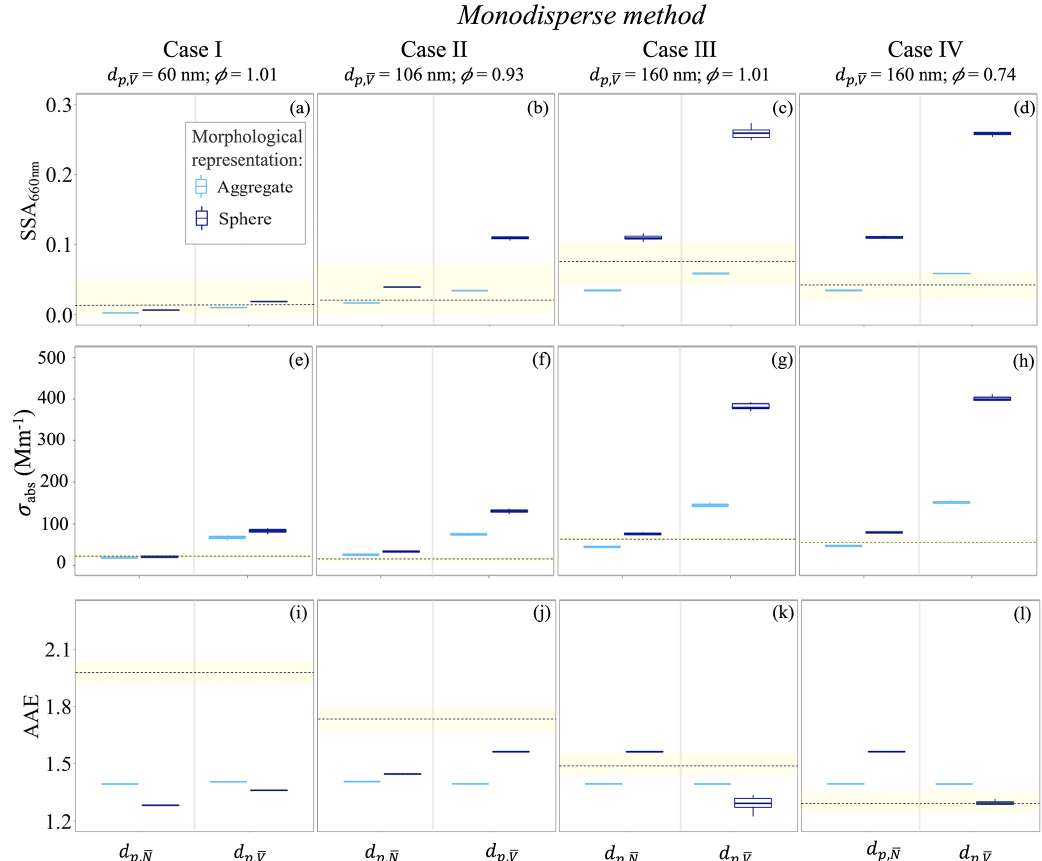
Figure 5. Optical properties of bare BC particles modelled using the monodisperse method compared to their measured values. Panels (a) – (d) show single-scattering albedo (SSA), and panels (e) – (h) show Ångström absorption exponent (AAE) for cases I–IV of E1. In each panel or case, the “sphere” and “aggregate” representations for bare BC particles were used, as shown in the legend. The SSA and AAE are modelled using both d and d ( x axis). The shaded yellow area represents the experimentally measured values, with the dashed line p ,N p ,V being the mean of the measured SSA or AAE. The lower hinge and the upper hinge of the boxplot represent the 25% and 75% quantile of the observations, respectively. The lower whisker is equal to the smallest observation greater than or equal to lower hinge − 1.5 × IQR (interquartile range). Similarly, the upper whisker is equal to the largest observation less than or equal to upper hinge + 1.5 × IQR. The meaning of these terms is consistent for boxplots through this